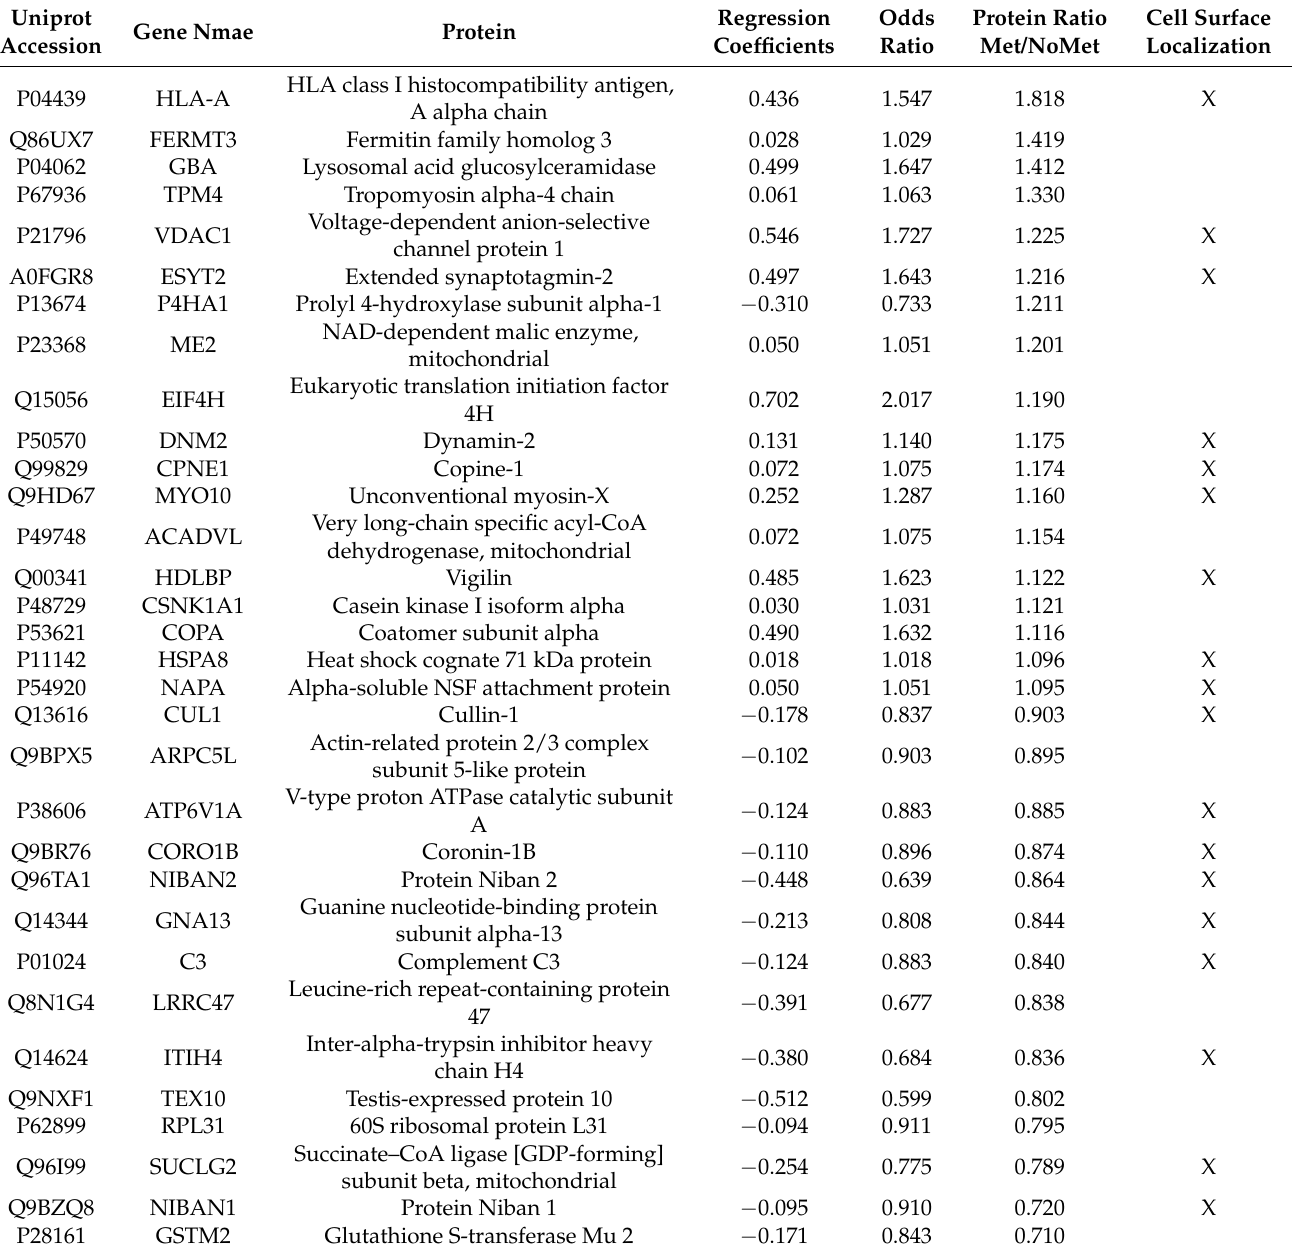
Table 3. Selected Proteins in the Final Prediction Model for UM